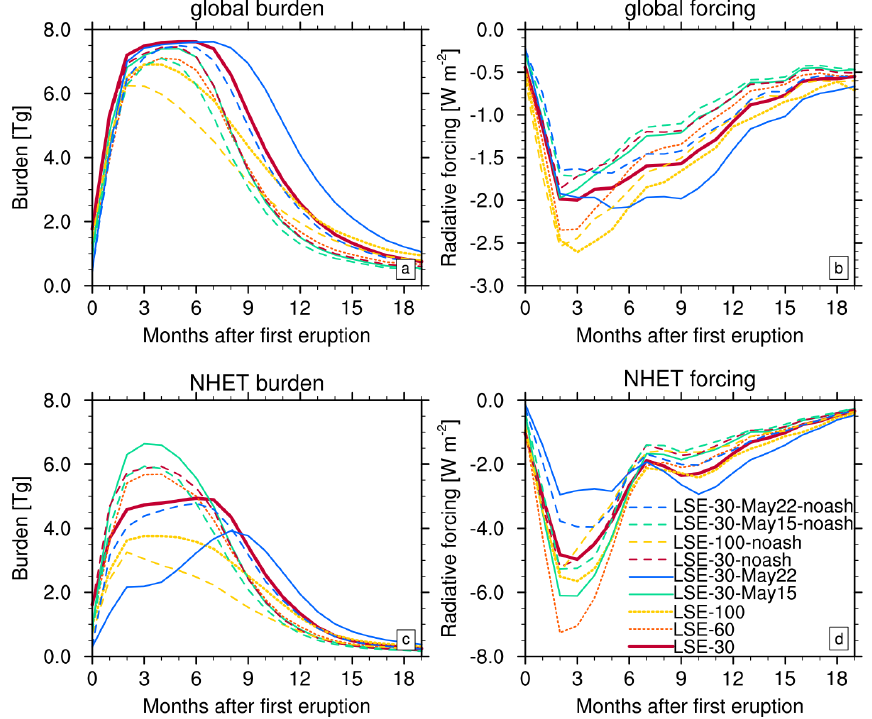
Figure 11. Area average of sulfur burden (a, c) and radiative forcing ( b, d , all sky, TOA) of sulfate aerosols over time. Top: global average. Bottom: average over the Northern Hemisphere extratropics (NHET, 30 to 90 ◦ N). Solid lines show the simulations with an initial injection of 15Tg SO 2 on different eruption days (LSE-30, LSE-30-May15, LSE-30-May22), dotted lines at different injection altitudes (LSE-60, LSE-100) and dashed lines simulations without the injection of fine ash (LSE-30-noash, LSE-30-May15-noash,